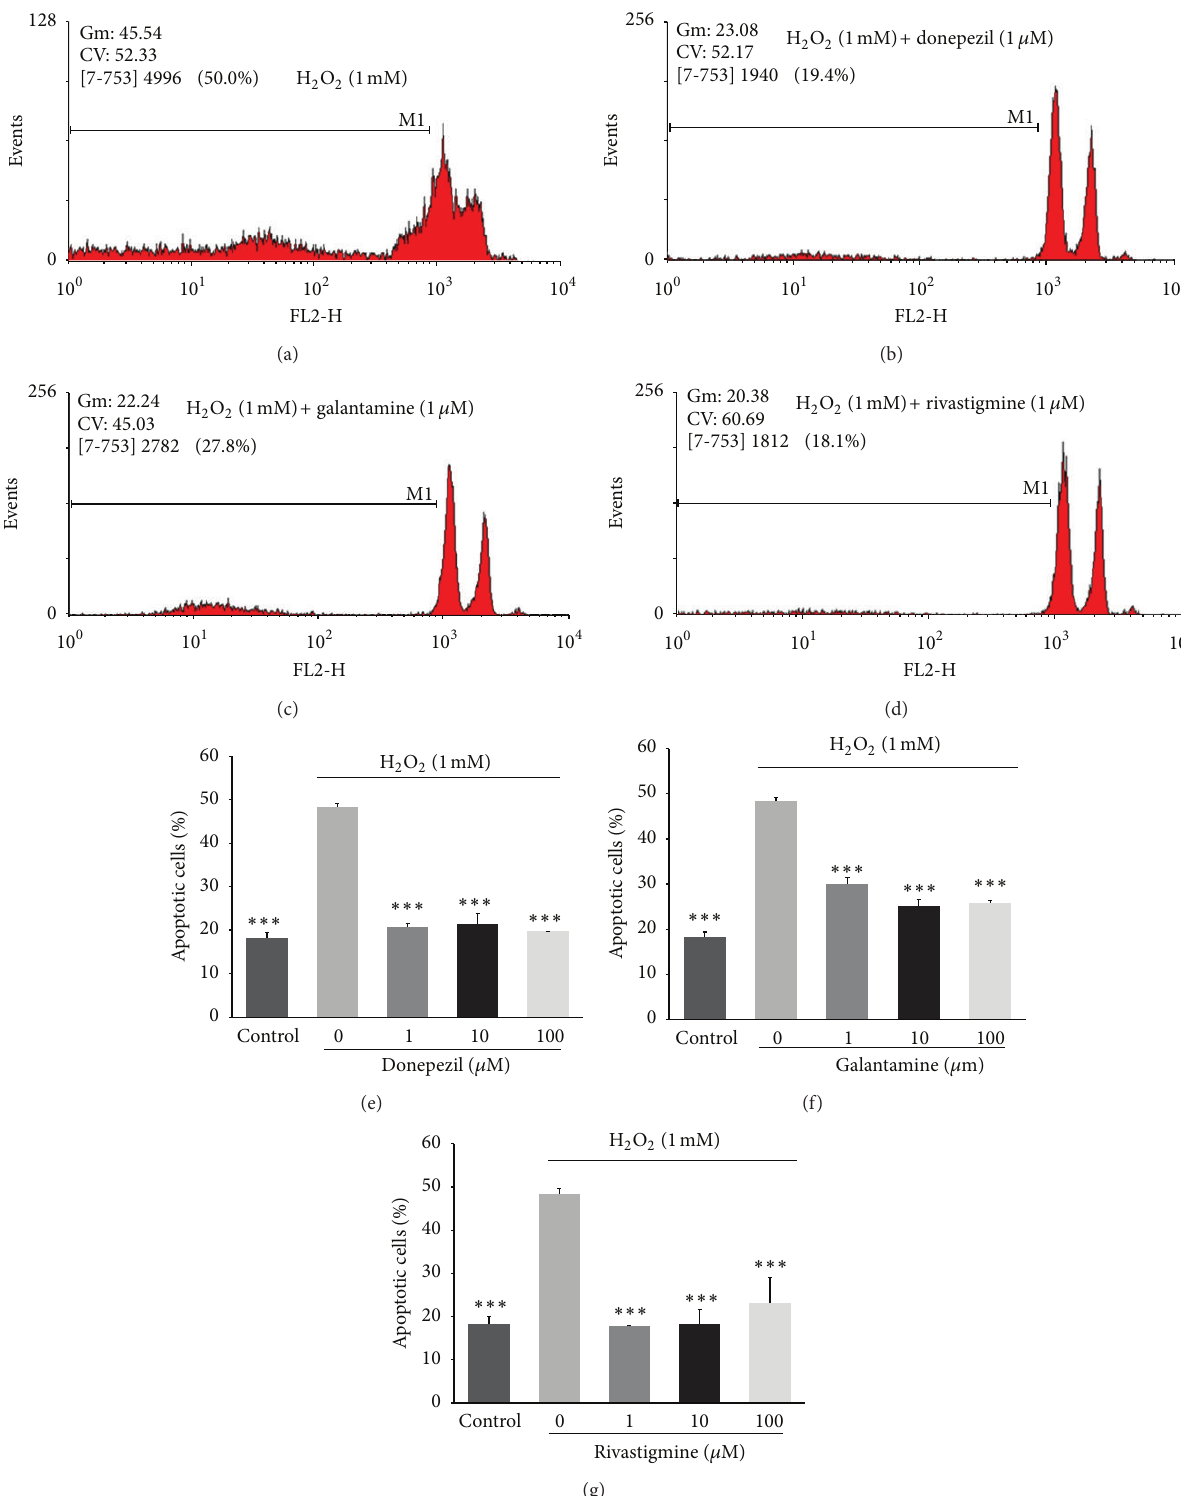
Figure2:EffectsofAChEinhibitorsonH 2 O 2 -inducedendothelialcellsapoptosis.TheHUVECswereseededovernightin12-wellcultureplate (50000 cells/well) and treated with donepezil, rivastigmine, and galantamine for 24h. Data are mean ± SD of two independent experiments performed in triplicate. ∗∗∗ 𝑃 < 0.001 versus untreated cells cultured in the presence of H 2 O 2